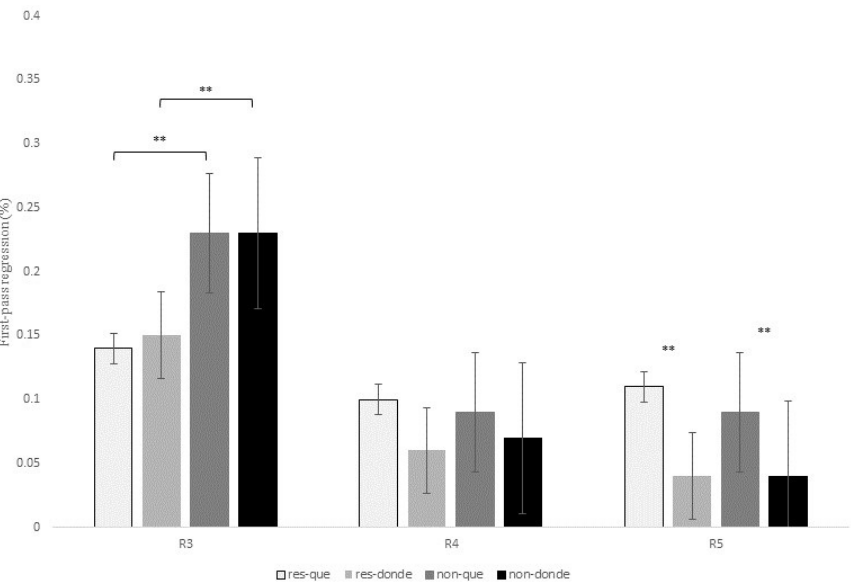
Figure 10. Probability of regression during the first-pass at regions 3, 4, and 5 for the contrast que versus donde in restrictive and non-restrictive RCs. Asterisks indicate that an effect is significant at p <